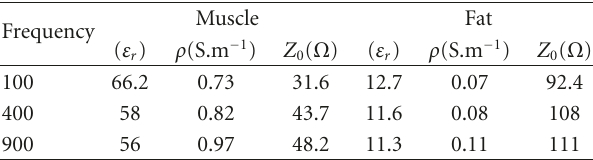
Table 1: Body electrical properties